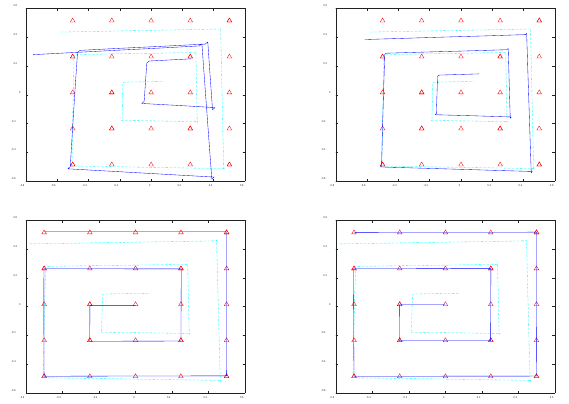
Figure 2: Estimated trajectory using GP-SLAM with the wrong σ f . (Top Left) σ f = 0.001, (Top Right) σ f = 0.010, (Bottom Left) σ f = 1.000, and (Bottom Right) σ f = 10.00. The cyan dash line shows the odometry only solution, the blue solid line indicates the GP-SLAM solution, and the red triangles are the ground truth.